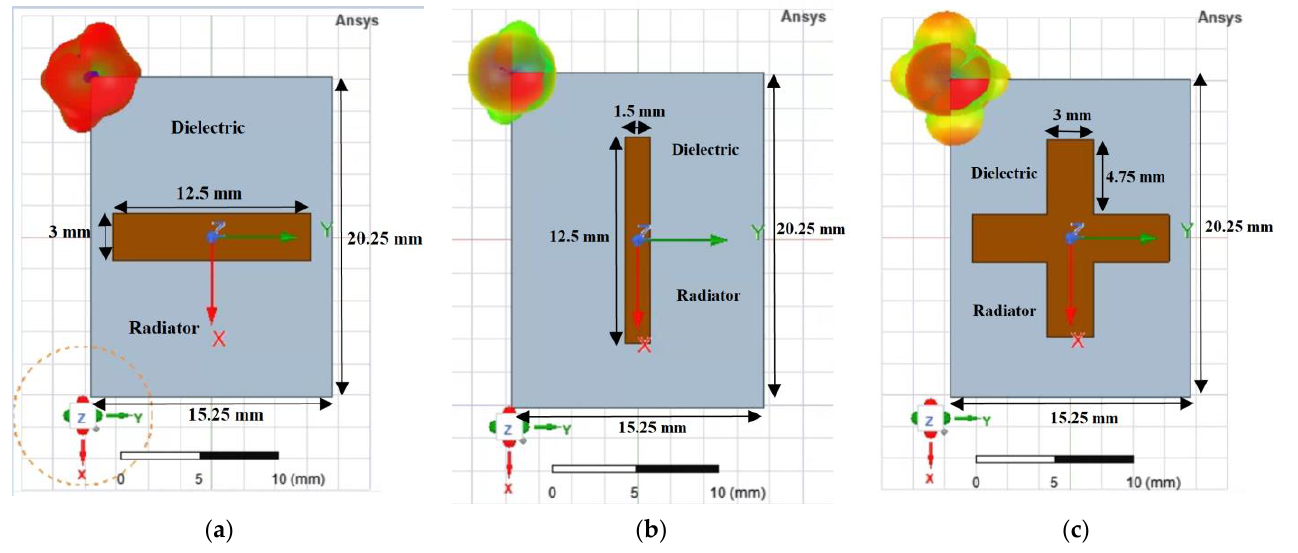
Figure 4. Unit cell: front and radiation pattern in x O y plane for radiators with “-”, “|” and “+” shapes.